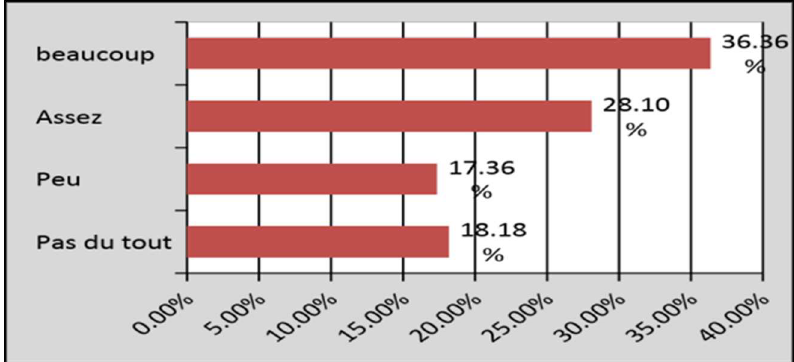
Fig. 1 La perception par les élèves de l’impact du TBI sur leur envie d’aller au